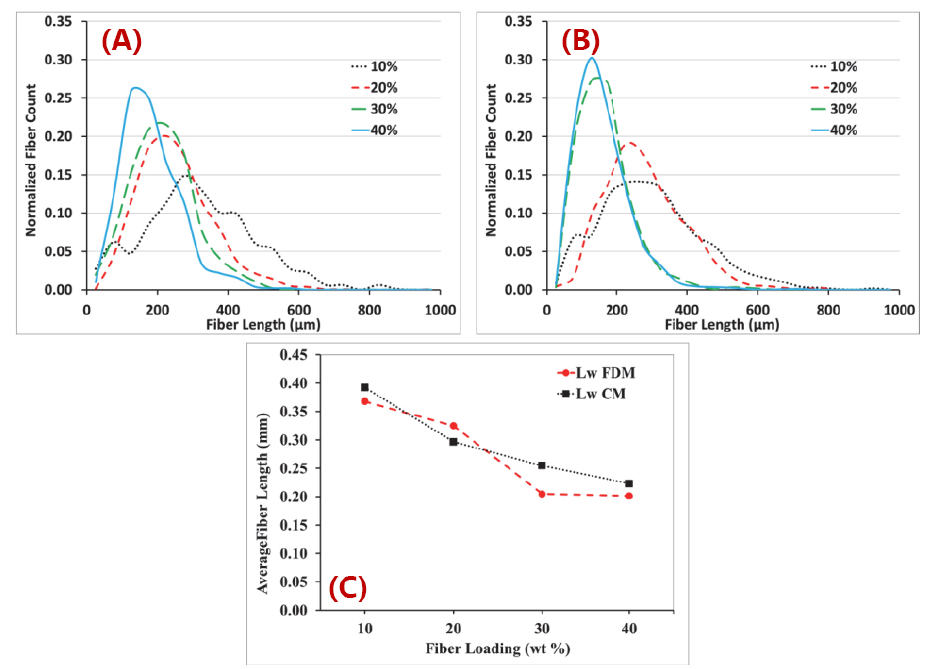
Figure 12. Fiber length distributions ( A ) compression-molded, ( B ) FDM-printed, and ( C ) weight average fiber lengths of dog bone samples [66].